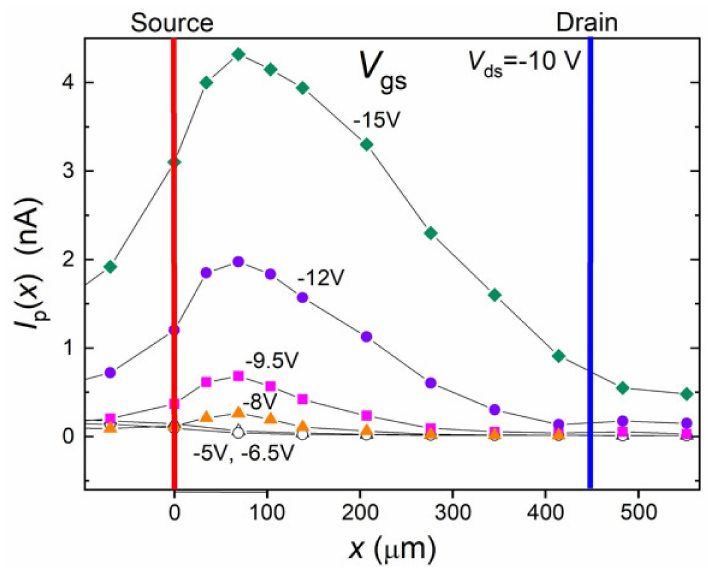
Figure 1. Spatial photocurrent I p (x) as a function of distance x measured from the source edge for the indicated voltages: − 5 V (open circles), − 6.5 (open triangles), − 8 V (orange triangles), − 9.5 V (magenta squares), − 12 V (blue circles), − 15 V (olive diamonds). Increasing the negative V GS above − 6.5 V and keeping the V DS constant, the transistor gradually transits from the off-state, where I p ( x ) is almost zero, to the on-state, in which the I p ( x ) signal starts to increase first near the source for V GS = − 8 V and − 9.5 V and then at the drain side for more negative gate voltages ( V GS < − 9.5